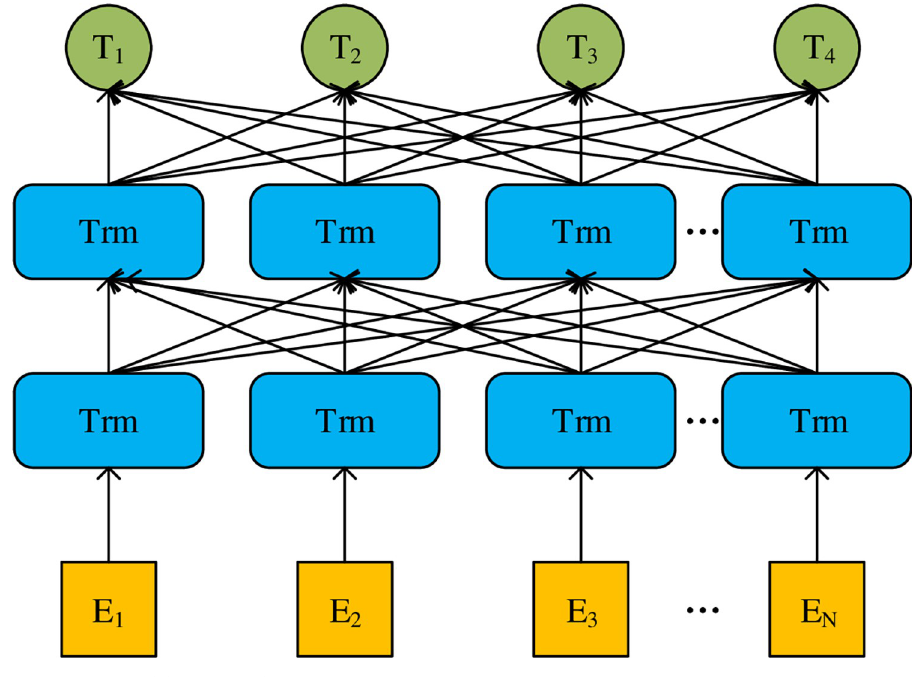
Fig 1. BERT model structure